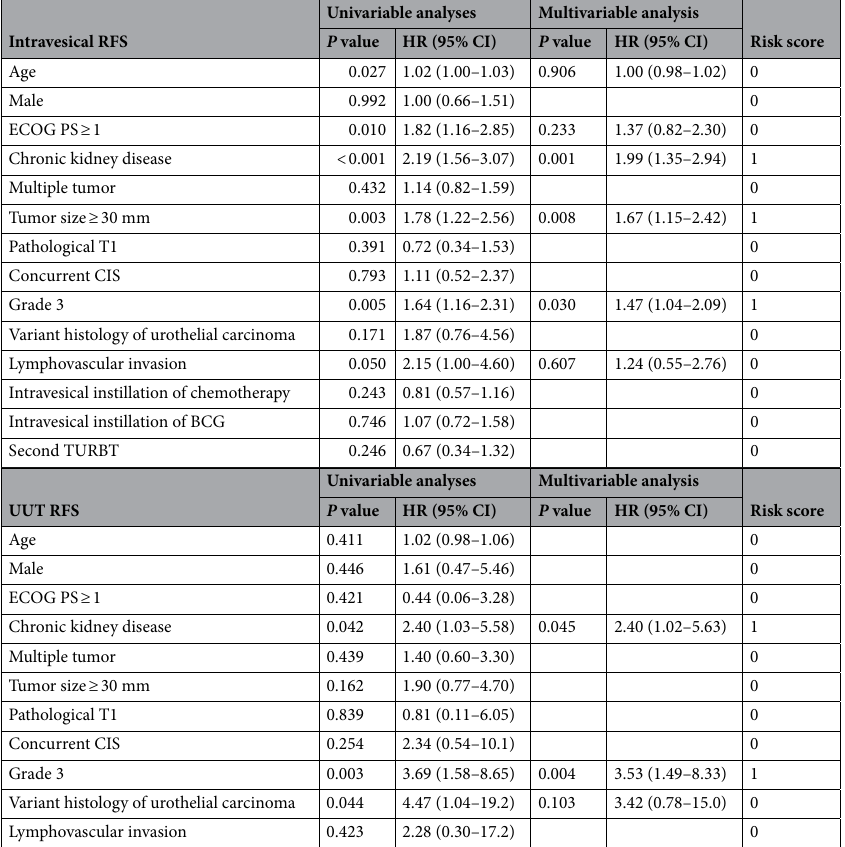
Table 3. Uni- and multivariable analyses for intravesical and upper urinary tract recurrence-free survival. RFS, recurrence-free survival; HR, hazard ratio; CI, confidence interval; ECOG PS, Eastern Cooperative Oncology Group performance status; CIS, carcinoma in situ; BCG, bacillus Calmette-Guérin; TURBT, transurethral resection of bladder tumor; UUT, upper urinary